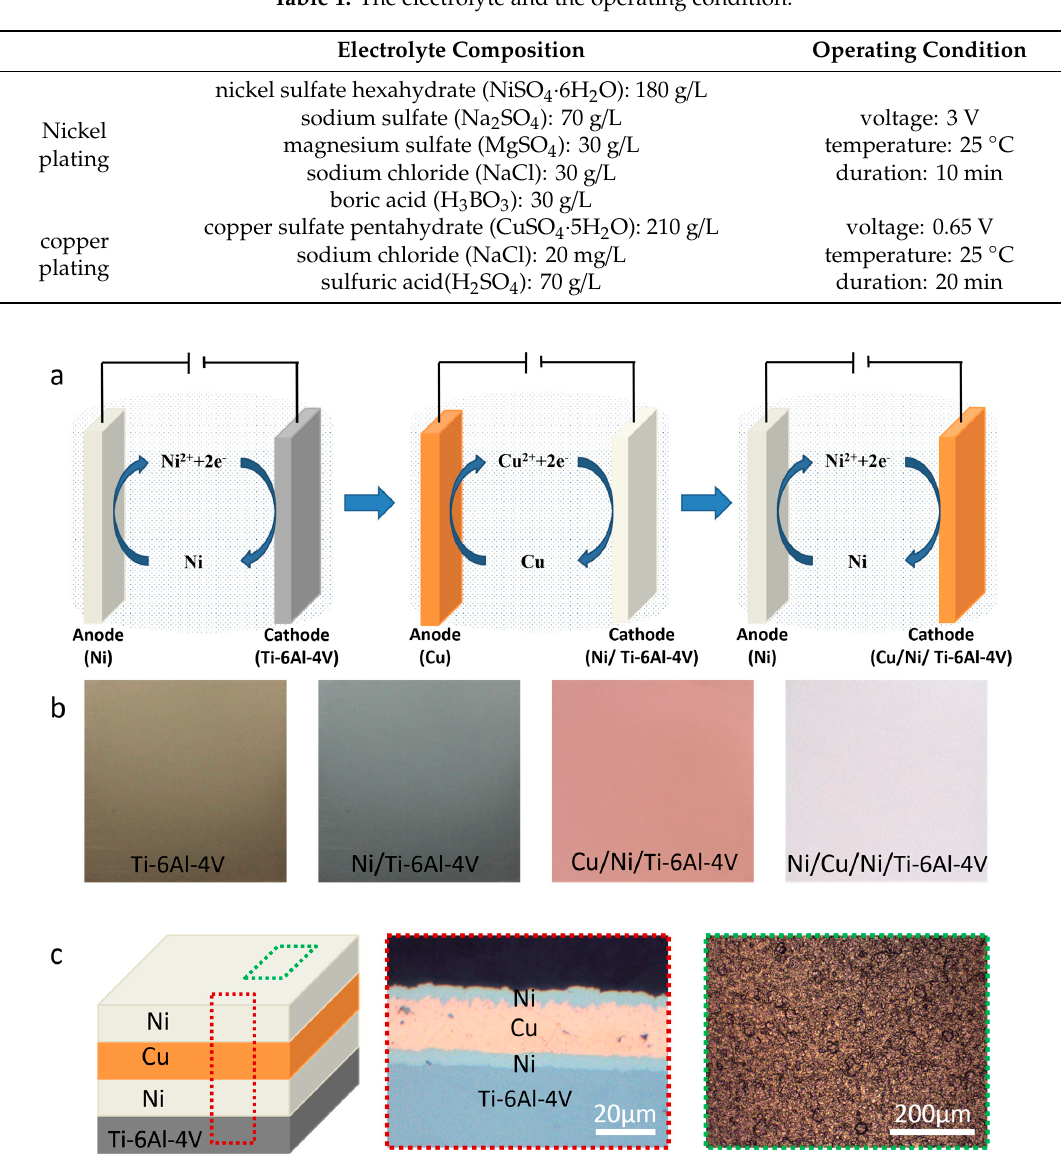
Figure 1. The Ti-6Al-4V electroplated Ni/Cu/Ni coating: ( a ) schematic diagram of preparation technology, ( b ) macroscopic photographs of samples during preparation, and ( c ) schematic